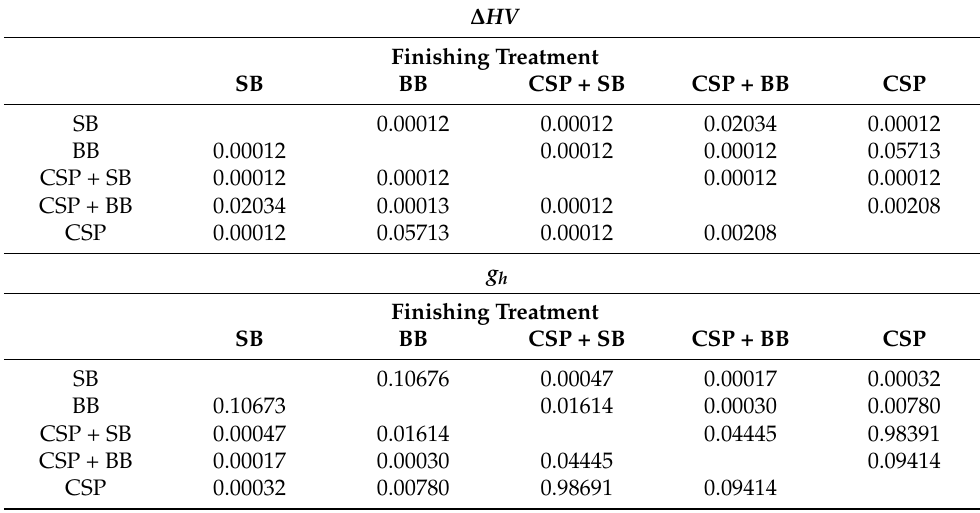
Table 4. Comparative analysis of the significance of differences (post-hoc/Tukey’s test) between the average values of increased microhardness ∆ HV and hardened layer thickness g h after treatment with different methods. The red color indicates the probability level for which there are statistically significant differences.